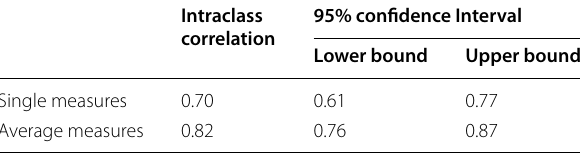
Table 2 Intraclass correlation